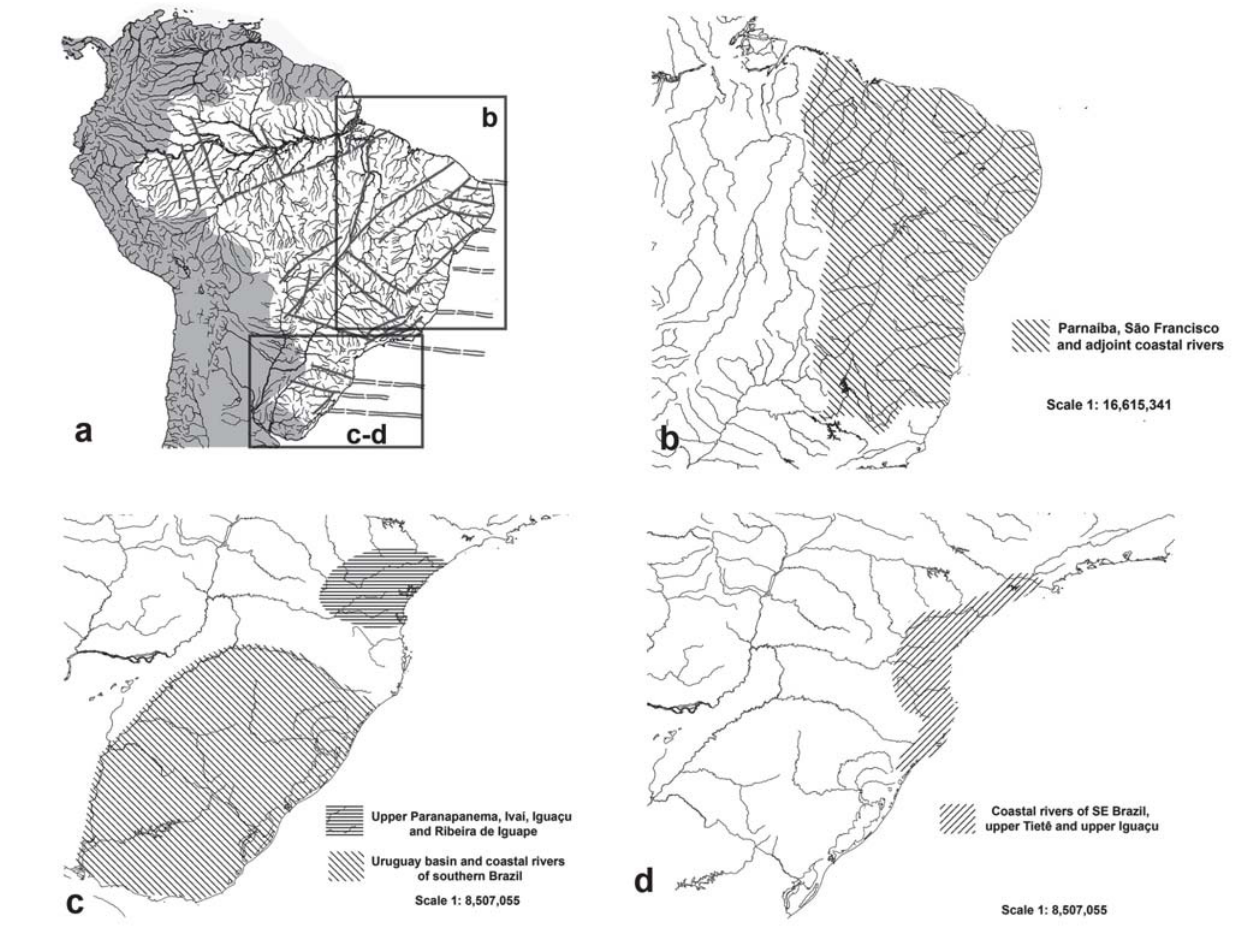
Fig. 11 . (a) The main axes of Quaternary tectonics in Brazil (gray lines) (according to Saadi, 1993) and areas of coincident distributional rages of several species in both isolated coastal rivers and adjacent drainages. (b) The northeastern margin of Brazil, including the Parnaíba, São Francisco and adjacent coastal rivers (c) The Southern most Brazil, encompassing the Uruguay and surroundings coastal rivers as well as the headwaters of the Paranapanema, Ivaí, Iguacú and Ribeira de Iguape. (d) The area encompassed by the CRSB, in southeastern Brazil, including the coastal rivers and the adjacent upper Tietê and upper